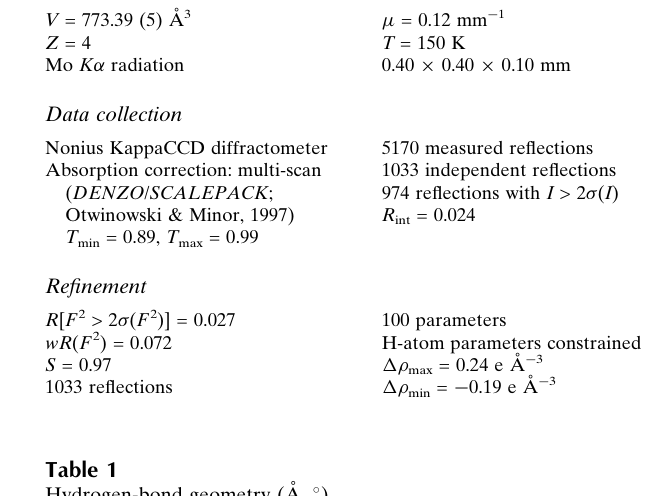
Hydrogen-bond geometry (A˚ , (cid:3)